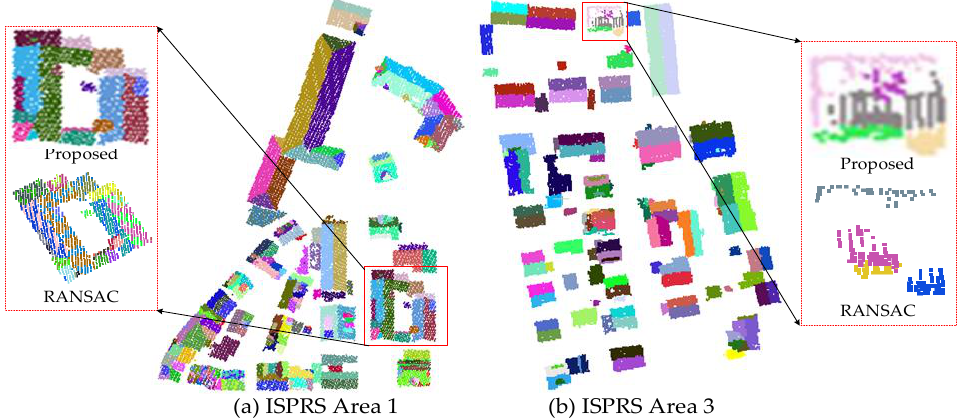
Figure 13. Results of roof plane extraction in comparison.